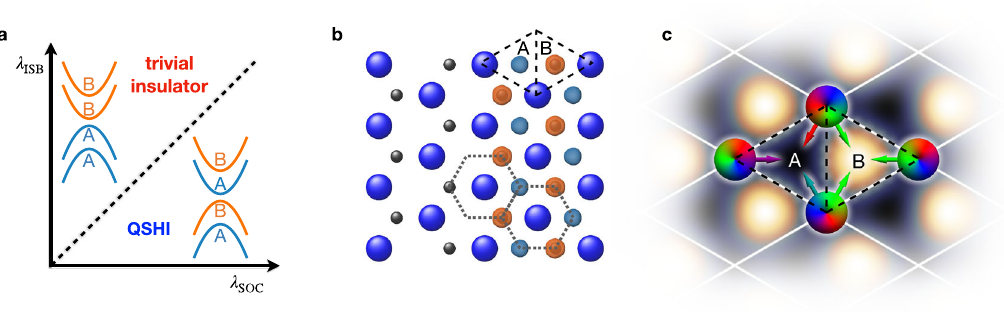
Fig. 1 Dirac fermions on a triangular lattice. a Sketch of the phase diagram as a function of SOC ( λ SOC ) and ISB ( λ ISB ). The insets illustrate the band ordering of the Dirac fermions at the K and K ′ points in the QSHI and trivial insulator phase. The coloring and the A/B labels correspond to the charge localization in b . b Triangular lattice (blue spheres) with substrate-induced ISB, as indicated by the C atoms (black spheres) in the fi rst bilayer of the SiC(0001) substrate (Fig. 3a, c). The right half shows a honeycomb lattice (dotted gray lines) emerging from the charge localization of the chiral Dirac states, which peaks in the voids of the triangular lattice. c Interference mechanism between Bloch and orbital phases determining the charge localization, shown schematically for the example of a p − orbital at the K -point: the total phases (indicated by the rainbow color scheme) of neighboring sites contributing to the Bloch wave function interfere constructively at the B site. This promotes a high (bright) charge density centered around B, while destructive interference suppresses the charge localization in the A